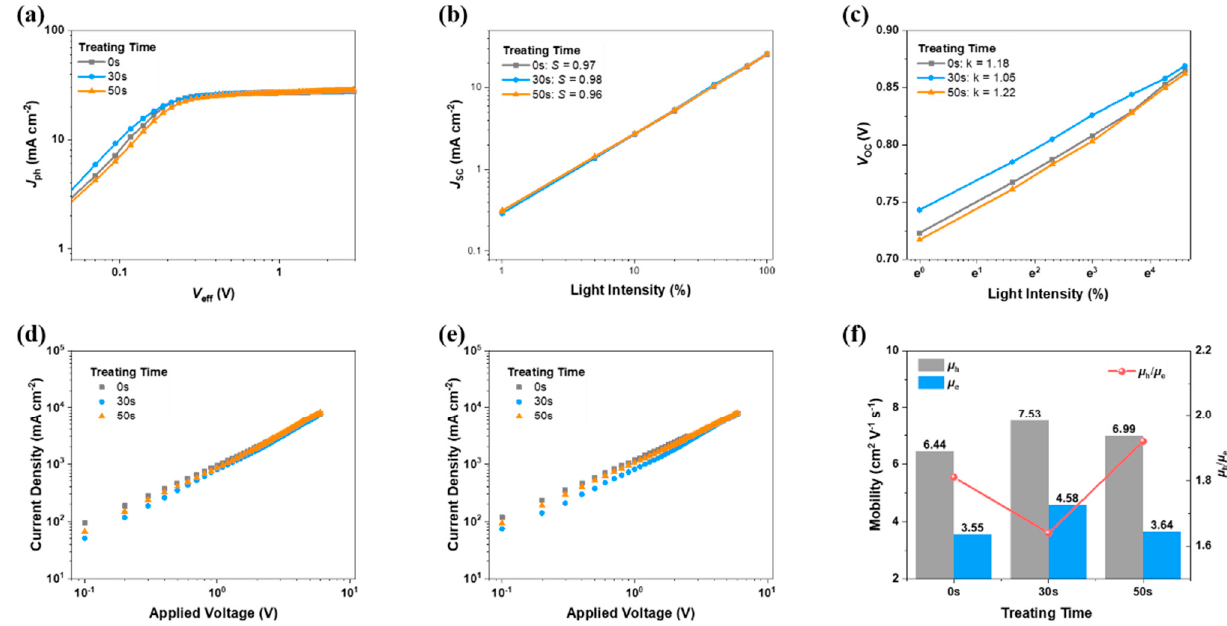
Figure 4. ( a ) J ph vs. V eff relationships. ( b ) J SC and ( c ) V OC vs. light intensity plots. Hole-only ( d ) and electron-only ( e ) device results. ( f ) summarized μ h , μ e and ratios.